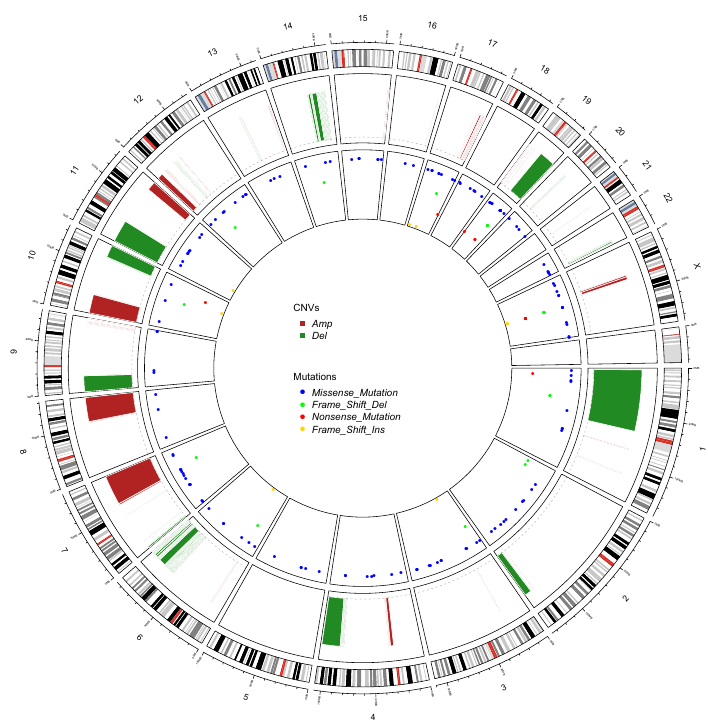
Figure 3. Circos plot of recurrent CNVs and mutations in